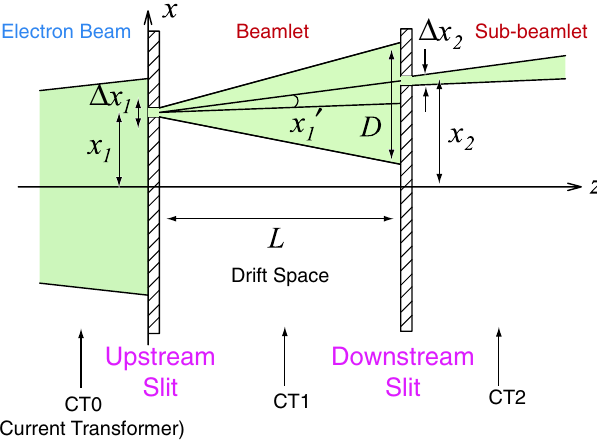
FIG. 8. (Color) Principle of emittance measurement. The verti- cal slits are omitted in the